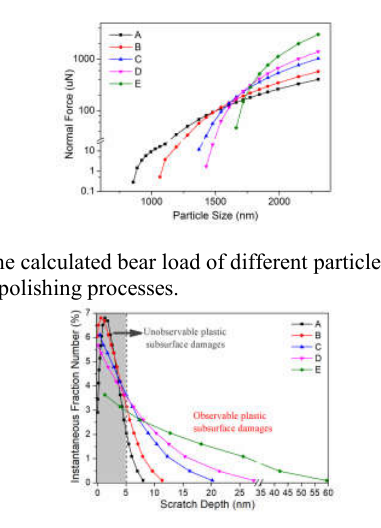
Fig. 3. The calculated instantaneous fraction number of scratches with different depth generated during a certain polishing time.